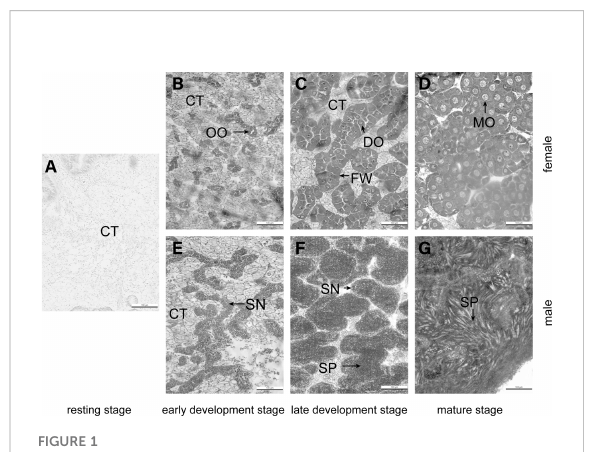
FIGURE 1 Histological observation on the gonad of Crassostrea angulata at 4 months of age. (A) resting stage, (B, E) early developmental stage, (C, E) late developmental stage, (D, G) mature stage. (B – D) female, (E – G) male. CT, connective tissue; FW, follicle wall; OO, oogonia; DO, developing oocyte; MO, mature oocyte; SN, spermatogonia, SP, sperm; bar, 100 m m.